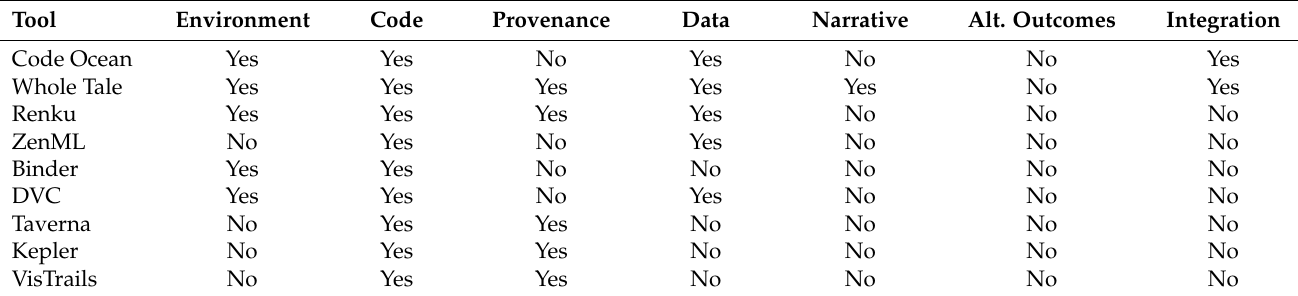
Table 1. Comparison between tools that aim to support “methods reproducibility” research. Tool Environment